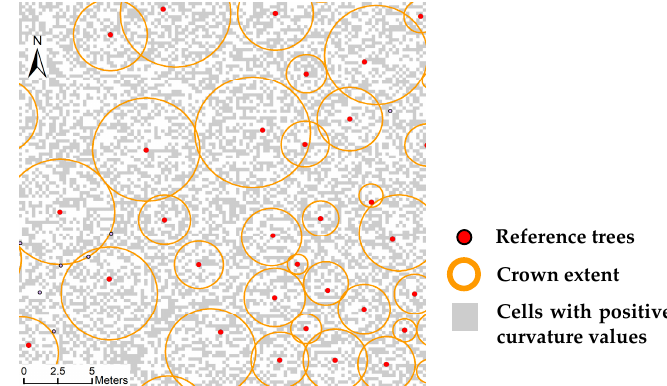
Figure 3. Extraction of cells with positive profile curvature values. A large positive local G i * indicates a local spatial pattern of clustering of large posi- tive profile curvature values, while a large negative one indicates clustering of large negative curvature values. The significance of a local spatial pattern can be measured by means of a statistical significance test. If the neighborhood size is larger than 8 observa- tions, the resultant distribution of local G i * is normal [48]. The statistic defined by Equa- tion (2) is in a Z-score standardized form. Consequently, to recognize significant spatial patterns, the local G i * values are directly compared with the critical value under a speci- fied significance level. If a local G i * value is beyond the critical value, the local spatial pattern is statistically significant [49]. In this study, to recognize the convex morphology of tree crowns, all cells with positive local G i * values beyond the critical value under a specified significance level are extracted. Figure 4a shows an example of cell extraction.